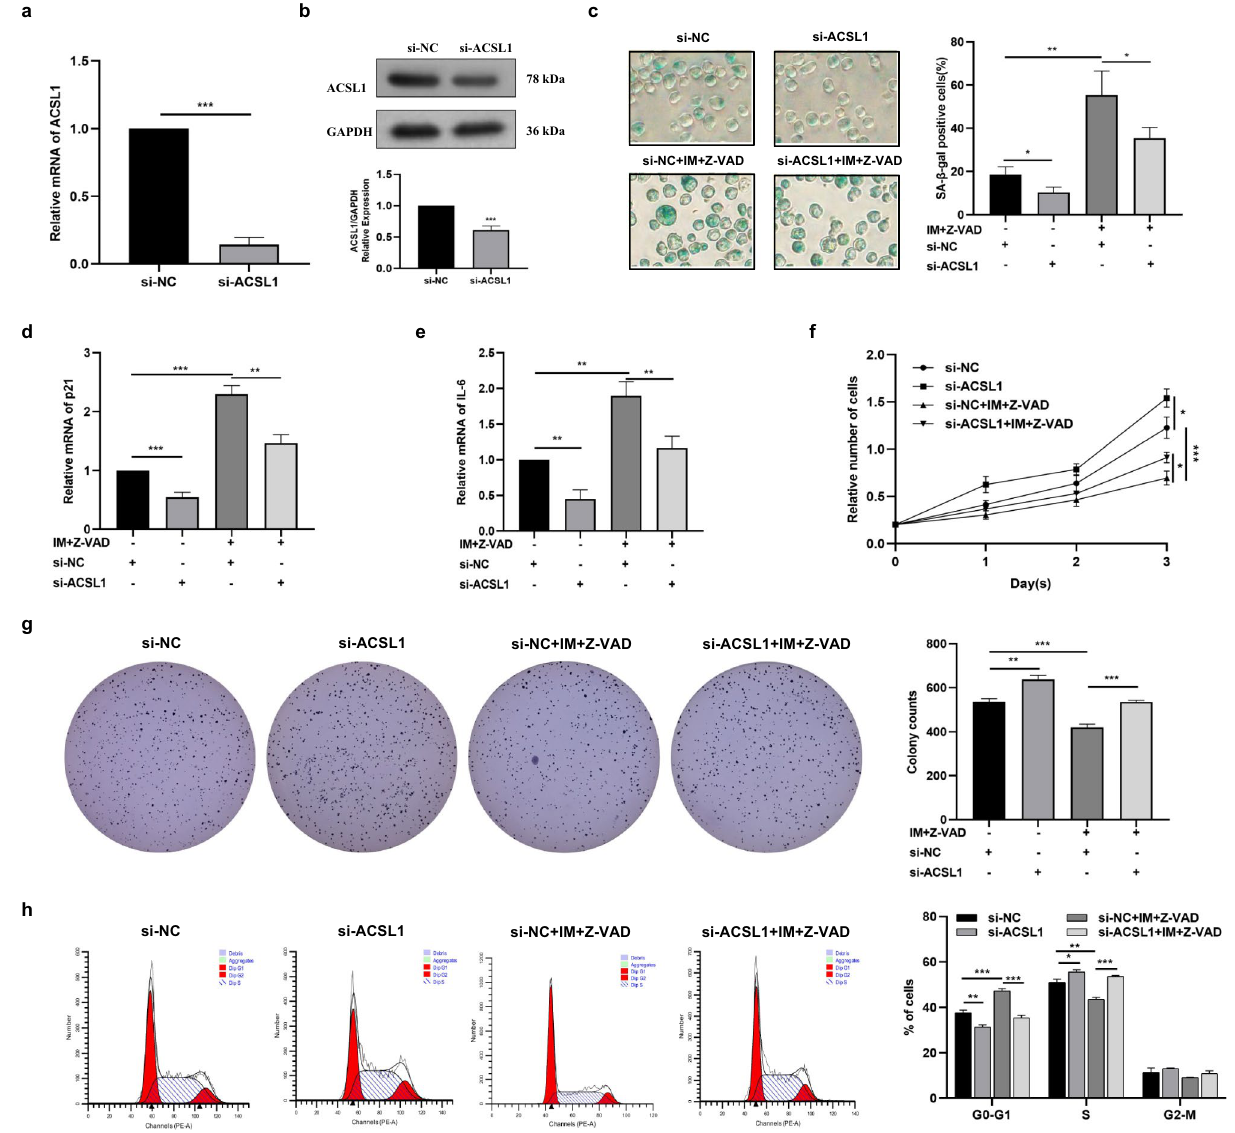
Figure 3. Knockdown of ACSL1 expression reverses imatinib-induced senescence in K562 cells. ( a , b ) Cells were transfected with si-NC or si-ACSL1. ( c ) Cell senescence analysis determined by SA-β-gal staining. ( d , e ) qRT-PCR was applied to quantify the relative expression of senescence-associated genes p21 and IL-6. ( f ) Cell proliferation analysis determined by CCK8 assay. ( g ) Cloning formation assay indicating the in vitro growth of K562 cells. ( h ) Cell cycle distribution analyzed using PI staining followed by flow cytometry. The data are presented as the mean ± SD of three independent experiments. *p < 0.05, **p < 0.01 and ***p <